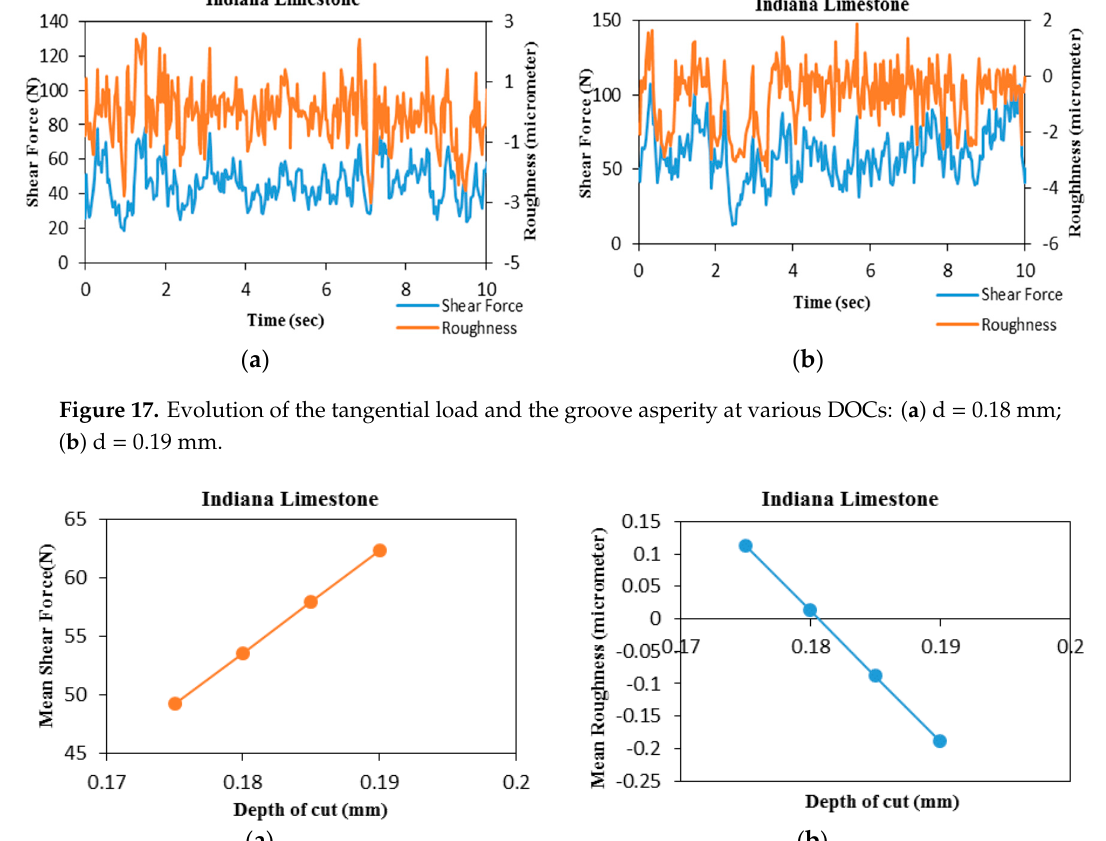
Figure 18. Evolution of the tangential load and the groove asperity at various DOCs: ( a ) d = 0.18 mm; ( b ) d = 0.19 mm.